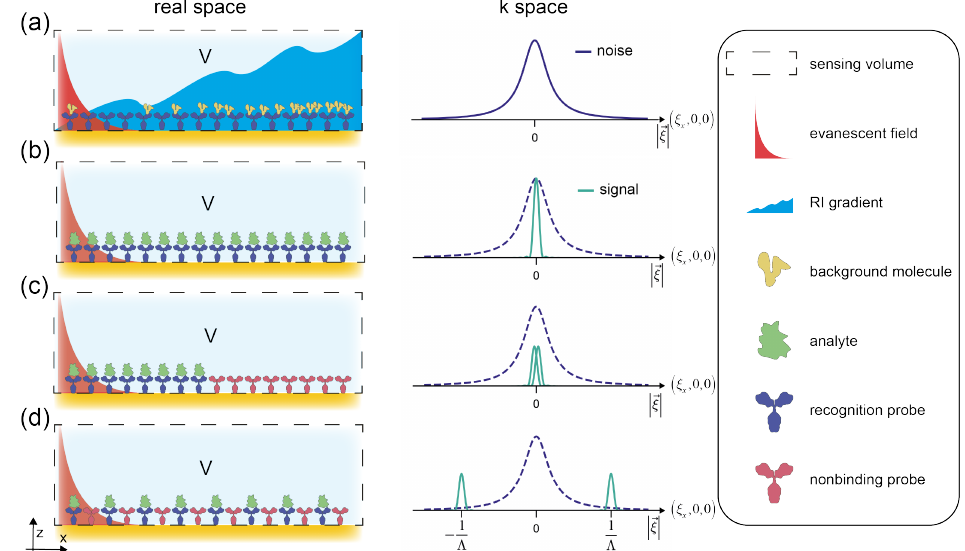
Figure 1. The spatial affinity lock-in concept. Environmental noise and signal distribution are shown for different sensor designs. In all cases, we assume a sensor that interrogates a volume close to its surface and detects changes in the refractive index within that volume. The second column shows the reciprocal space (also known as momentum or k-space) distribution of binding signal and environmental noise. ( a ) Typical environmental noise sources such as temperature gradients or non-specific binding of background molecules, are ‘long’ ranged. They usually exhibit a dominant correlation mechanism and display a Lorenzian shape in momentum space. ( b ) An integrative sensor with the analyte molecules bound uniformly has a spectral distribution of the signal centered around zero spatial frequency in reciprocal space where most of the environmental noise is situated. ( c ) A traditional referenced sensor still has most of the signal at DC and there is a significant spectral overlap between the two signal lobes because the modulation period is of similar size as the sensor dimension. ( d ) A locked-in sensor has a lock-in period that is much smaller than its lateral dimension. The signal lobes are clearly separated, and the signal is situated at spatial frequencies where there is hardly any environmental noise. As a remark, because we simply want to illustrate the concept, we have neglected a zero-frequency component that is because we cannot put a negative mass analyte molecule onto the reference. Also, we neglected all higher harmonics that are due to the rectangular distribution of biomolecular mass in this